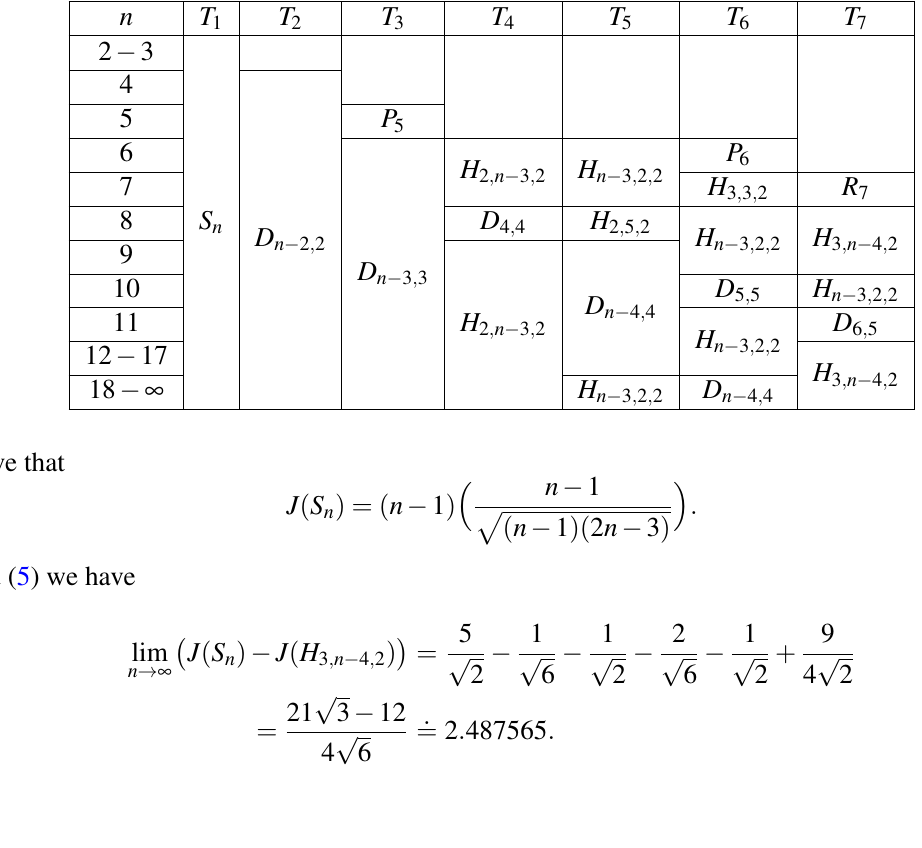
Table 1 First seven trees with maximal values of Balaban